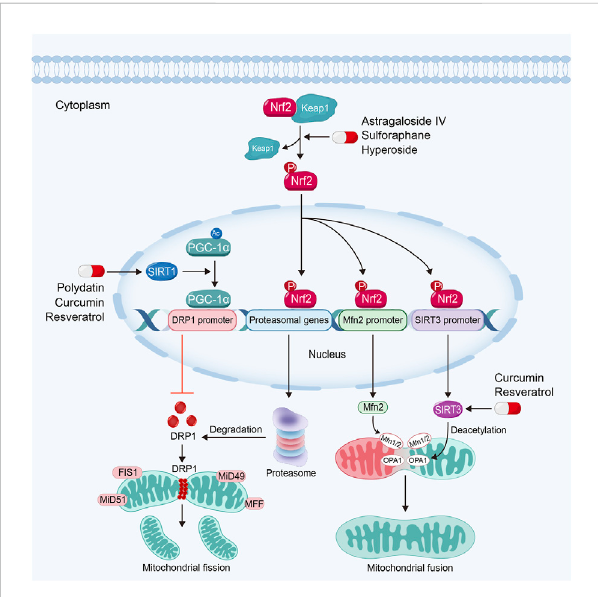
FIGURE 5 Sirtuin activators such as polydatin, resveratrol and curcumin regulate mitochondrial dynamics via sirtuin-1-PGC-1 α -DRP1 pathway and the activation of OPA1 by sirtuin-3 in kidney diseases. Nrf2 activators inhibit mitochondrial fi ssion and promote mitochondrial fusion in kidney diseases by Nrf2-proteasomal genes/ Mfn2/sirtuin-3 signaling